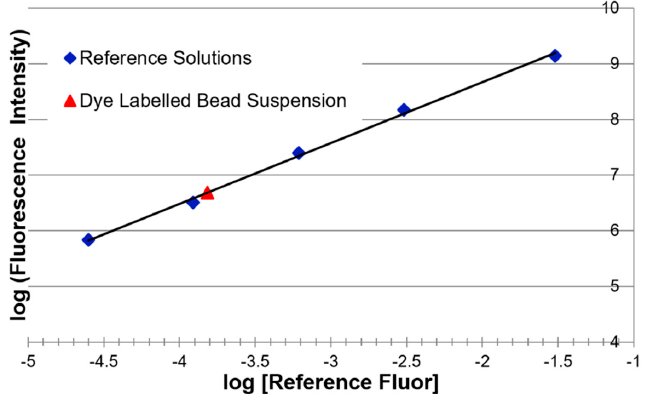
Figure 3. Calibration curve for fluorescence intensity as a function of reference fluorophore Figure3. Calibrationcurveforfluorescenceintensityasafunctionofreferencefluorophoreconcentration. concentration. The curve is used to express the measured fluorescence intensity of the bead The curve is used to express the measured fluorescence intensity of the bead suspension in terms of the suspension in terms of the equivalent reference fluorophore concentration. equivalent reference fluorophore concentration. Materials 2020 , 13 , x FOR PEER REVIEW